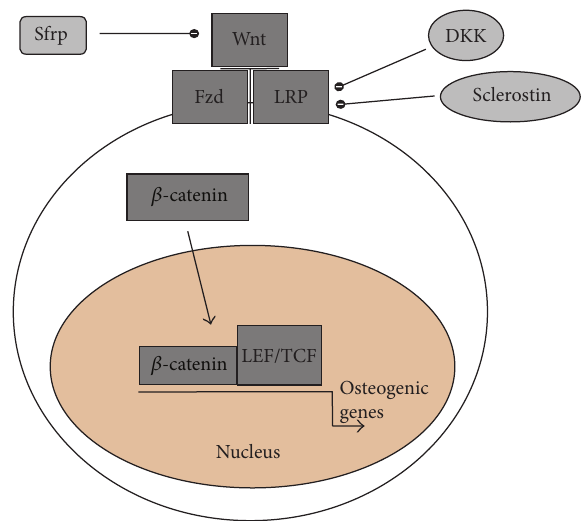
Figure 1: A simplistic illustration of the Wnt/ 𝛽 -catenin cellular sig- nalling pathway in an osteoblast. Activation of the Frizzled- (Fzd-) LRP5/LRP6 receptor complex at the plasma membrane by Wnt proteins brings about accumulation of 𝛽 -catenin in the cytoplasm, which then translocates to the nucleus, where it activates the LEF/TCF transcription factors, regulating expression of osteogenic genes; Sfrp suppresses Wnt activation and Dickkopf (Dkk) and sclerostin bind to LRP5 and LRP6 blocking the Wnt signalling [18,